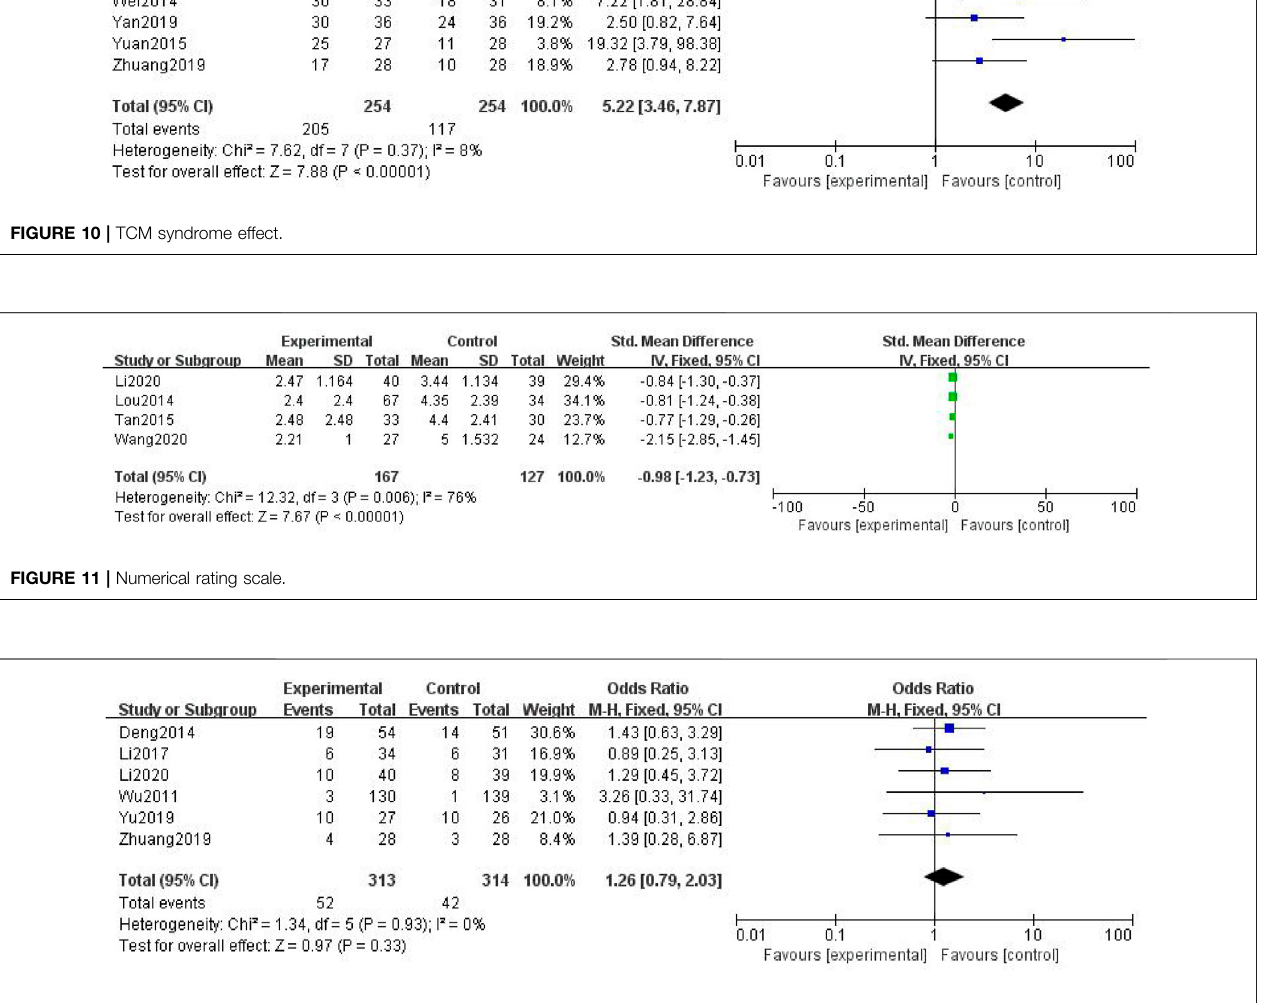
FIGURE 12 | Myelosuppression.